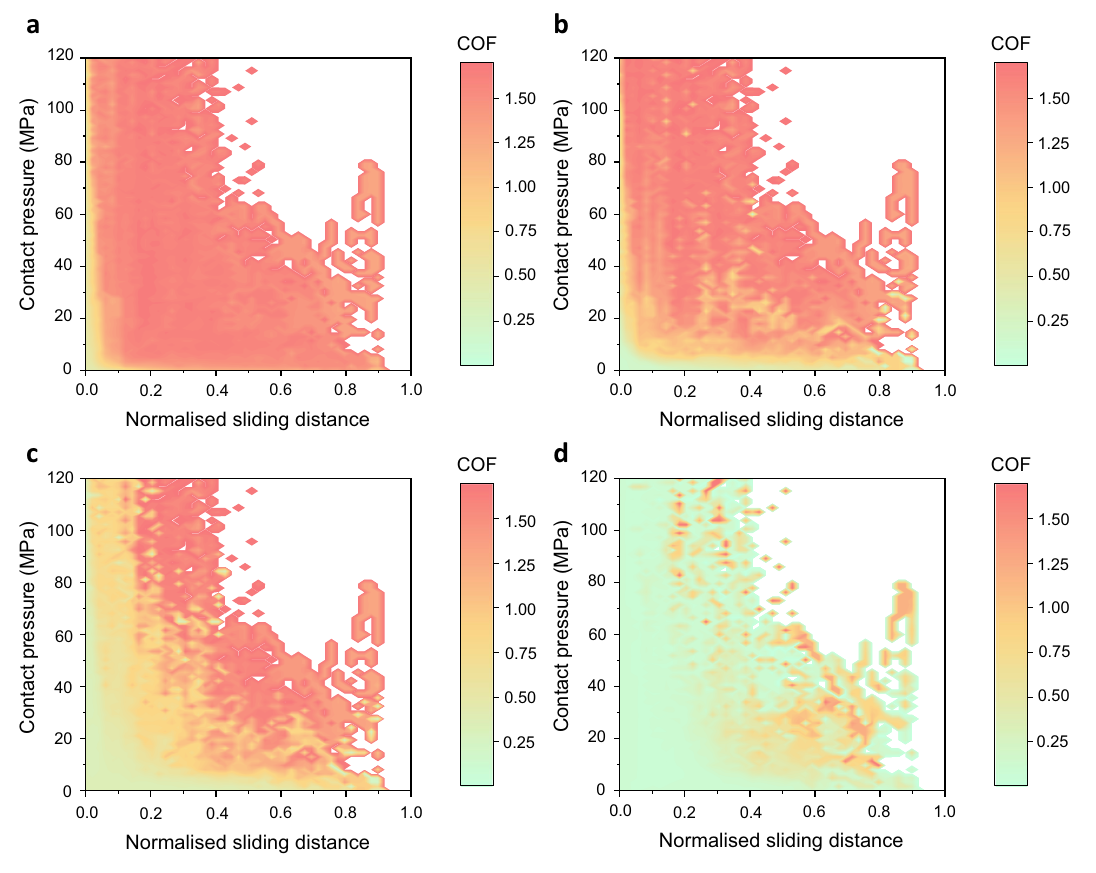
Fig. 2 | Digitally enhanced evaluation of four lubricants applied in the hot stamping process via the lubricant limit diagram (LLD) demonstrated by the